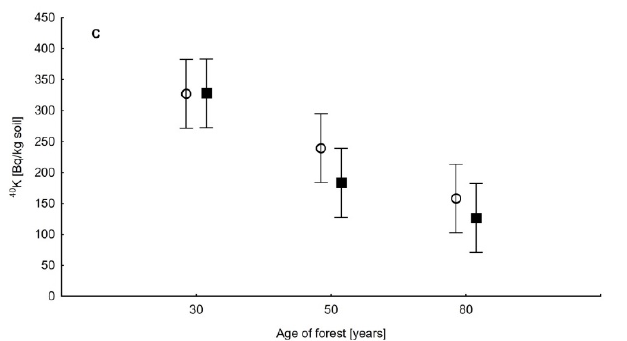
Figure 2. Activity of 40 K in wood ( A ), litter ( B ), and soil ( C ) in pine (P) and birch (B) stands of different ages (mean ± confidence level).